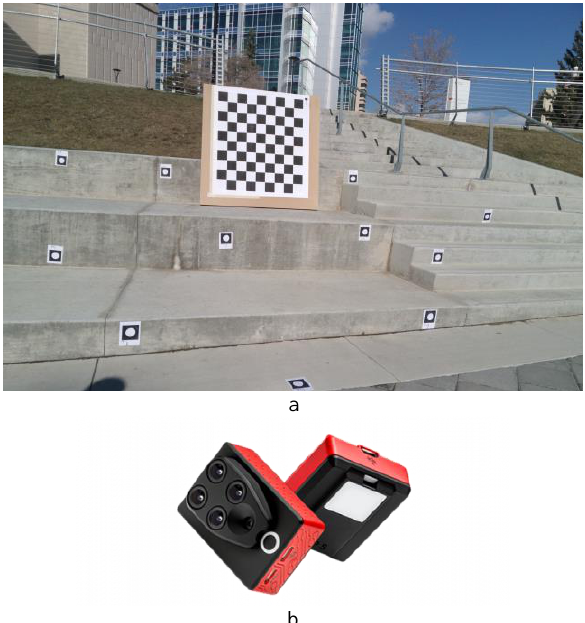
Figure 1. a) Parrot Sequoia multispectral camera with its sunshine sensor (source: parrot.com); b) Multi-depth test field used for self-calibration